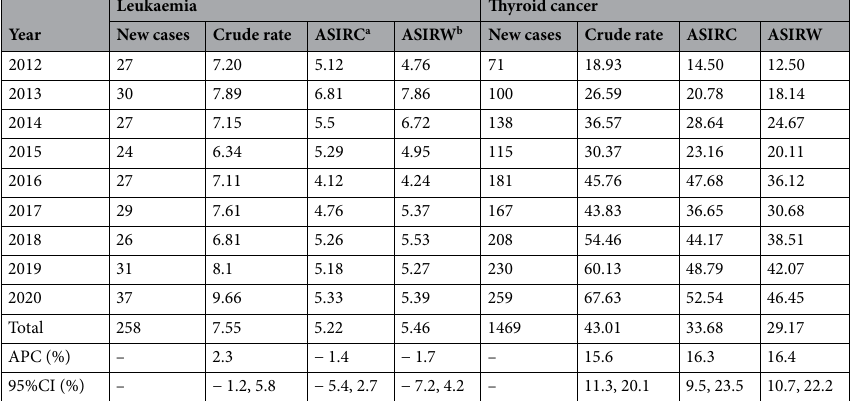
Table 11. Leukaemia and thyroid cancer incidence around Qinshan NPP from 2012 to 2020 (1/100,000). a Age-standardized incidence rate by Chinese 2000 standard population. b Age-standardized incidence rate by WHO 2000 standard